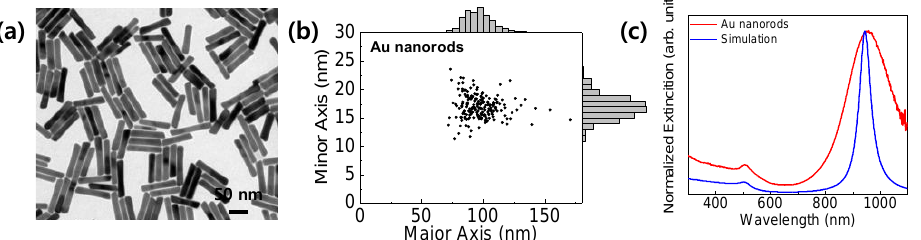
Figure 1. ( a ) TEM image of Au nanorods and ( b ) size distribution of purified Au nanorods. ( c ) Com- parison of the extinction spectrum of purified Au nanorods and that obtained via simulation.